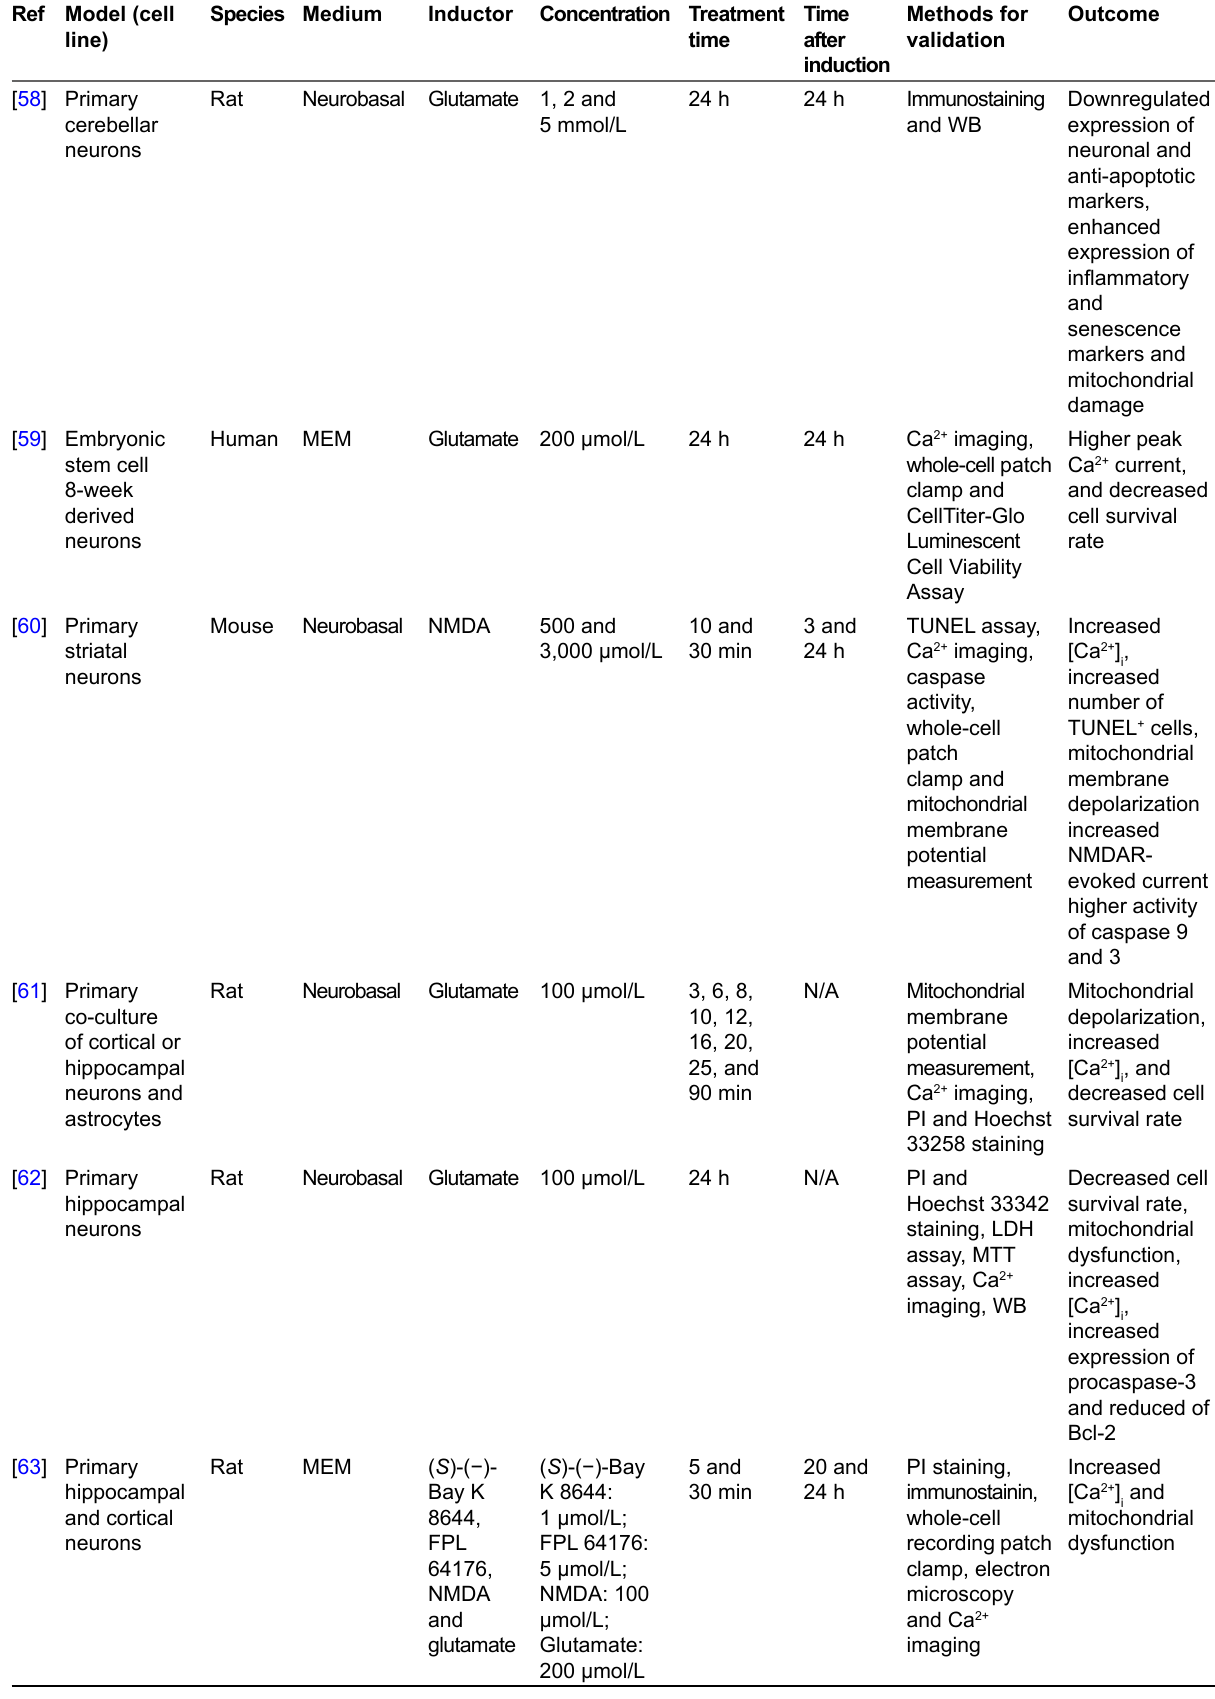
Table 1. Experimental aspects used in published excitotoxicity papers ( continued ) Ref Model